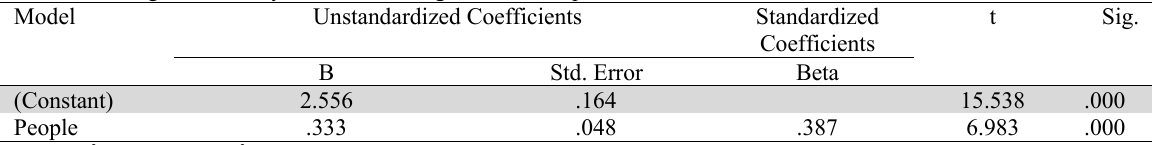
Table 4 The results of regression analysis for examining the effect of process on customer culture